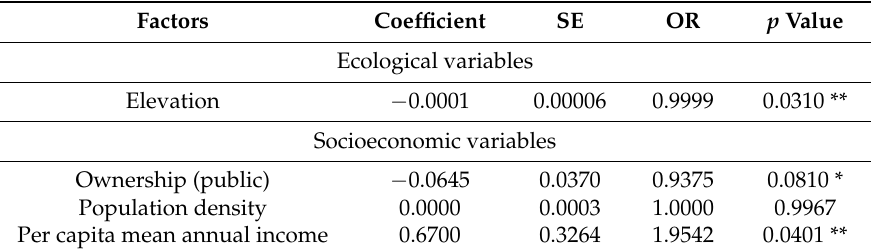
Table 3. Empirical results of major factors affecting the presence of invasive trees at the county level on Mississippi forestlands based on the spatial lag